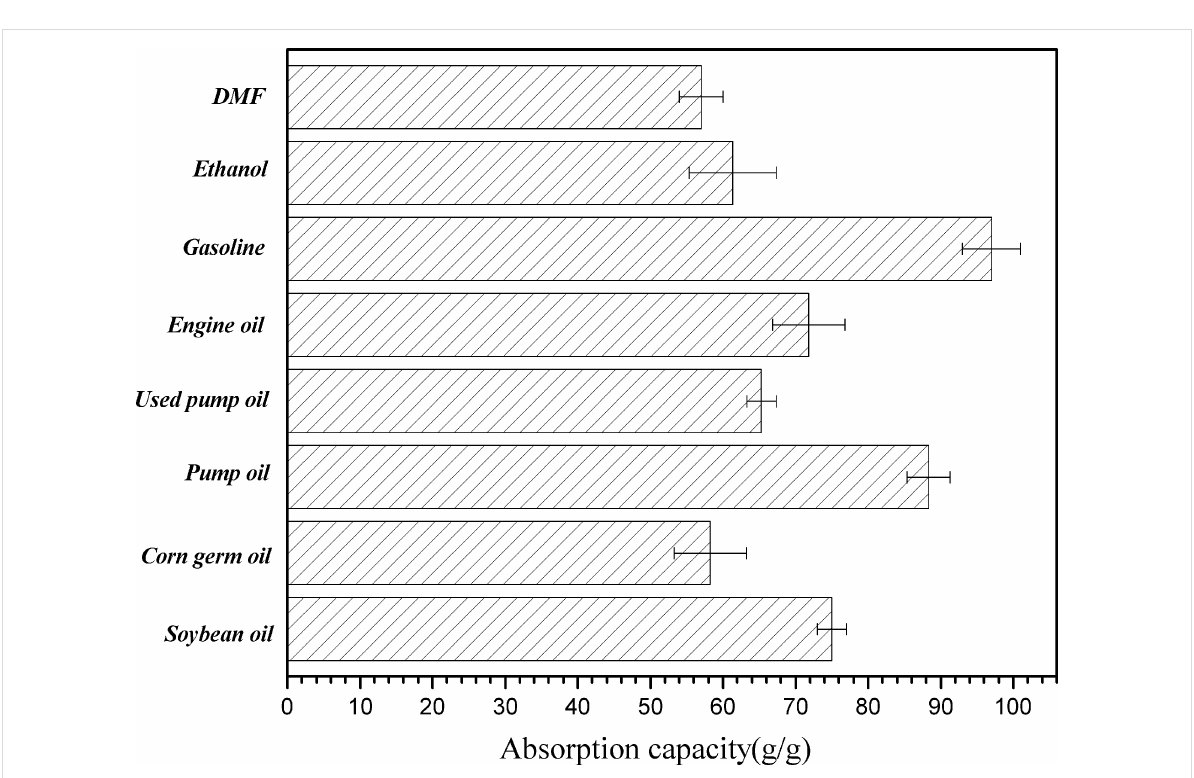
Figure 11: Absorption capacity of CNF/PVA/GO carbon